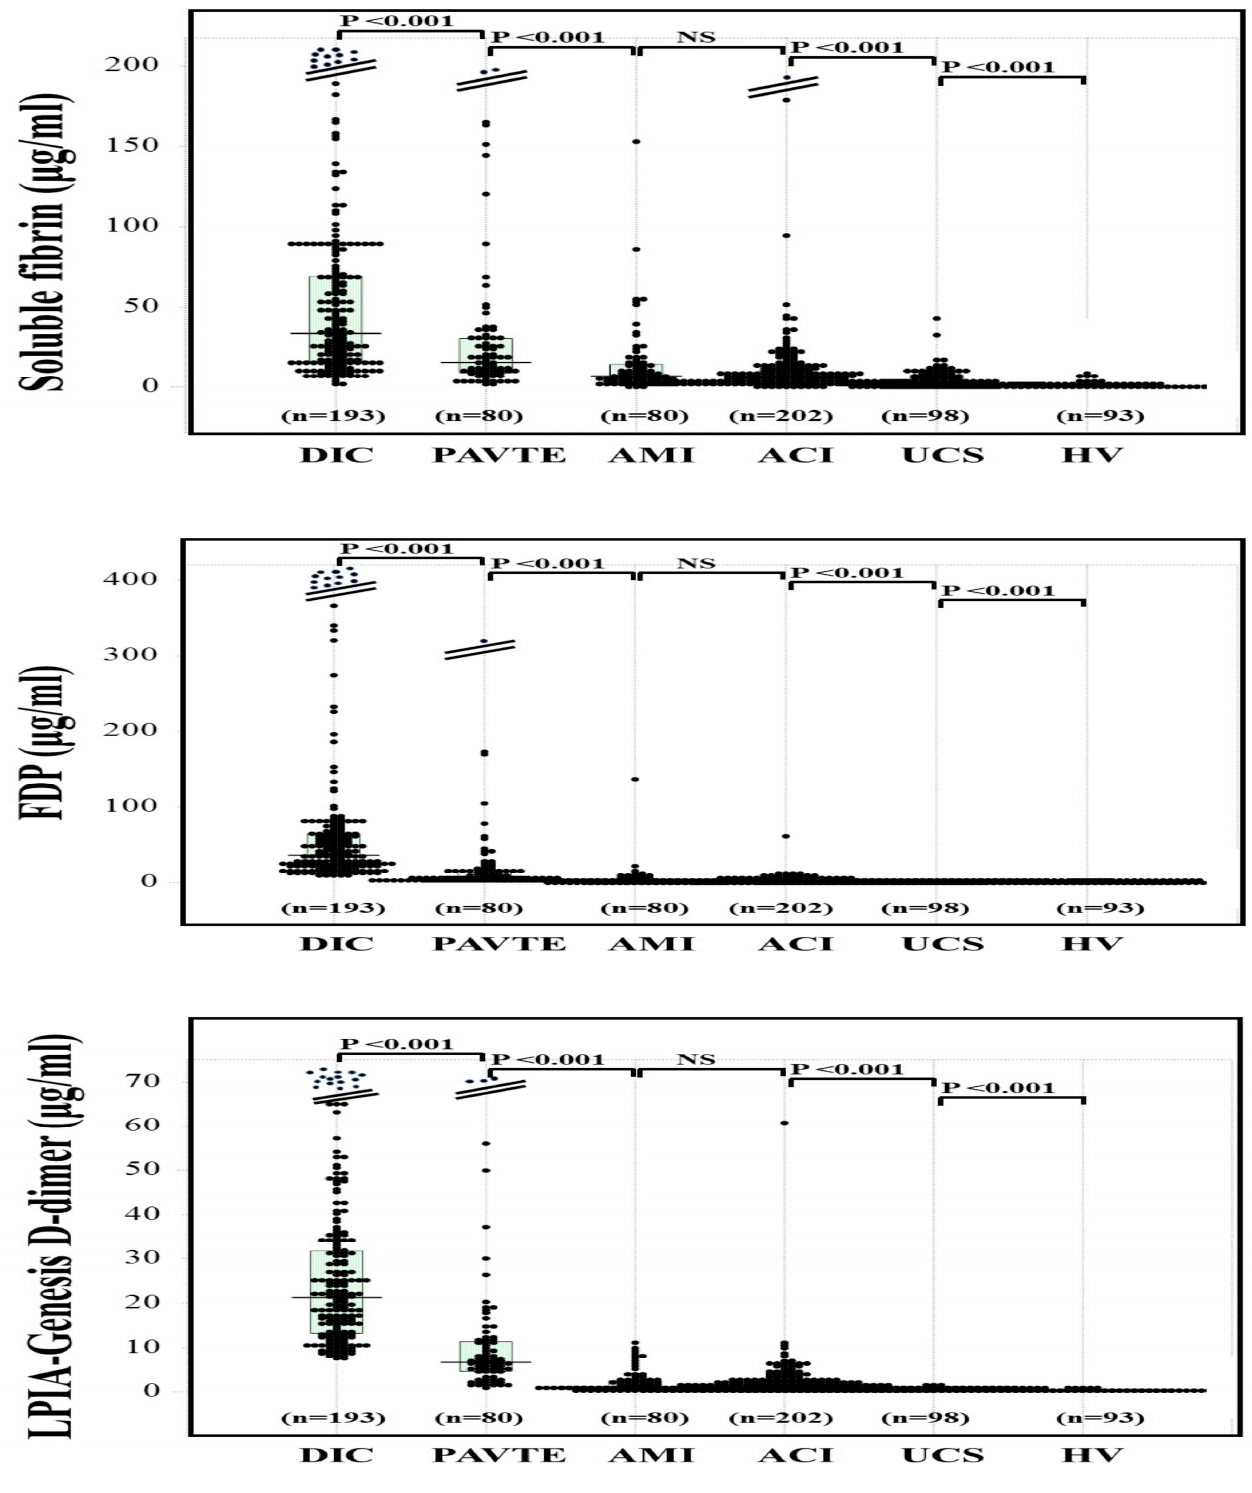
Figure 1. Plasma levels of soluble fibrin ( a ), FDP ( b ) and LPIA-Genesis D-dimer ( c ) in DIC, VTE, PATE, AMI, ACI, UCS, and HV. DIC, disseminated intravascular coagulation; VTE, venous thromboem- bolism, PATE, peripheral arterial thromboembolism, AMI, acute myocardial infarction; ACI, acute cerebral infarction; UCS, unidentified clinical syndrome; HV, healthy volunteers; FDP, fibrinogen and fibrin degradation product.